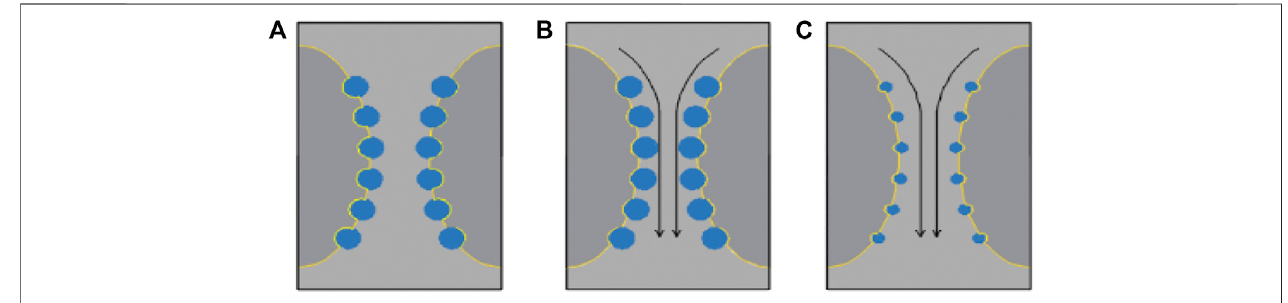
FIGURE 6 | Position distribution of particles and bubbles in foam. (A) Particles with poor wettability (B) Particles with good wettability (C) Too small particles.